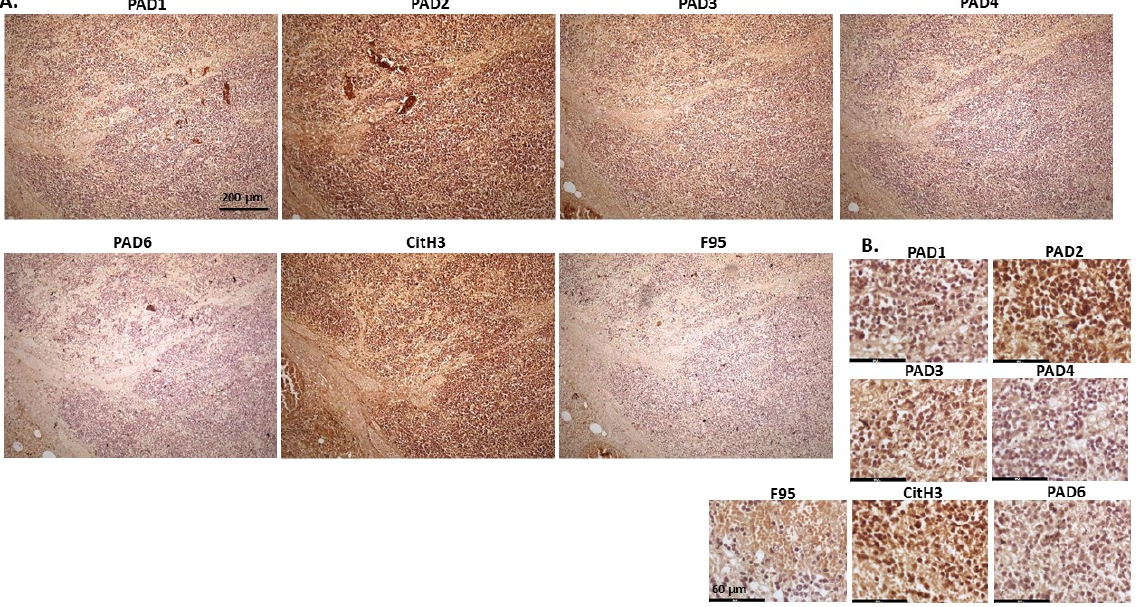
Figure 7. Mink, malignant renal tumour, probably nephroblastoma. Cadaver, mink, male. Extensive necrosis and haemorrhage in tumour mass. ( A ) Overview images for PAD1, 2, 3, 4, 6, CitH3, and F95 stainings of serial tissue sections; scale bar represents 200 µ m for all images; 10 × objective. ( B ) Higher magnification shown for each staining from the images in ( A ); scale bar represents 60 µ m for all images; 40 × objective.